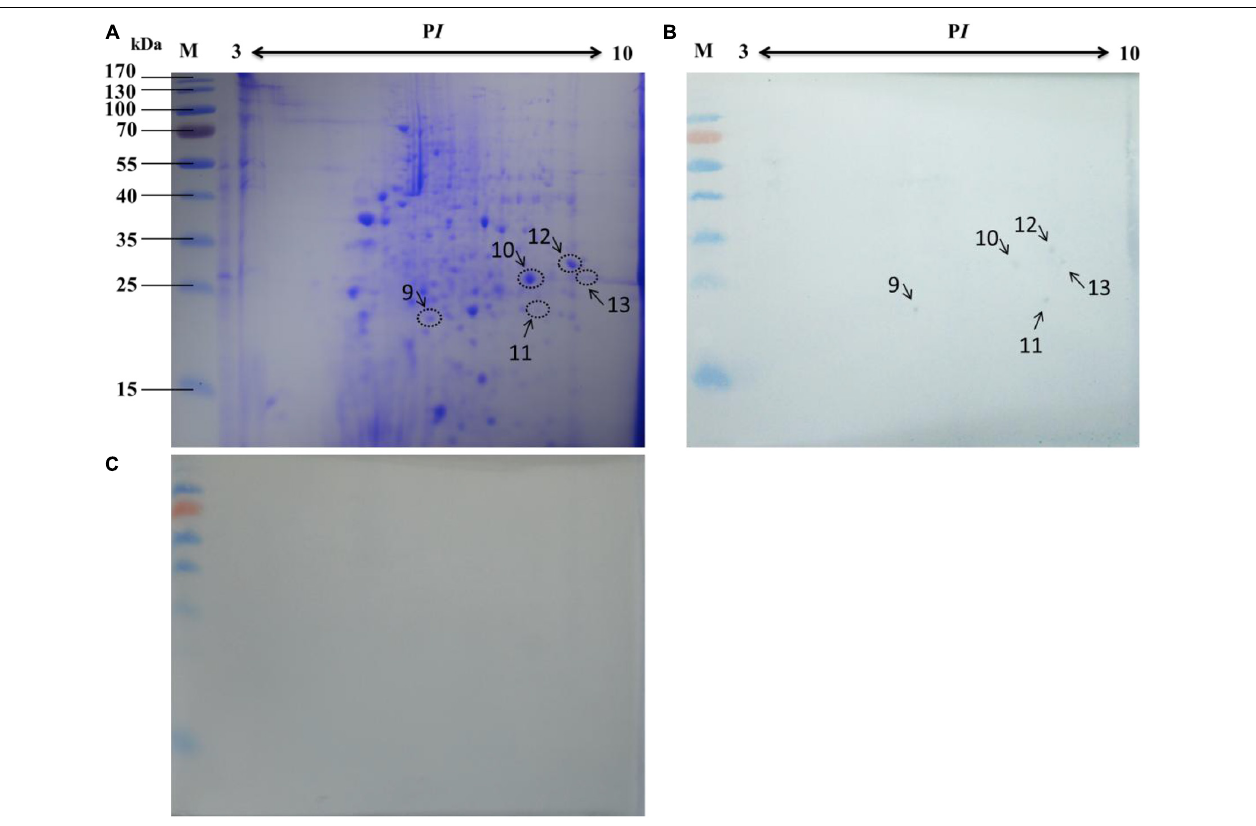
FIGURE 5 | Identification of virus-binding in the microsomal proteins fraction of the P50 midgut on 2-DE. (A) Bombyx mori midgut microsomal proteins submitted to 2-DE. Microsomal proteins blot were overlaid (B) or not ( C ; negative control) with BV, and antibodies against the AcMNPV gp64 protein were used to detect the BVs. Arrows 9–13 in (A,B) refer to the spots detected on corresponding proteins in the stained gel and the PVDF membrane. M, protein molecular weight